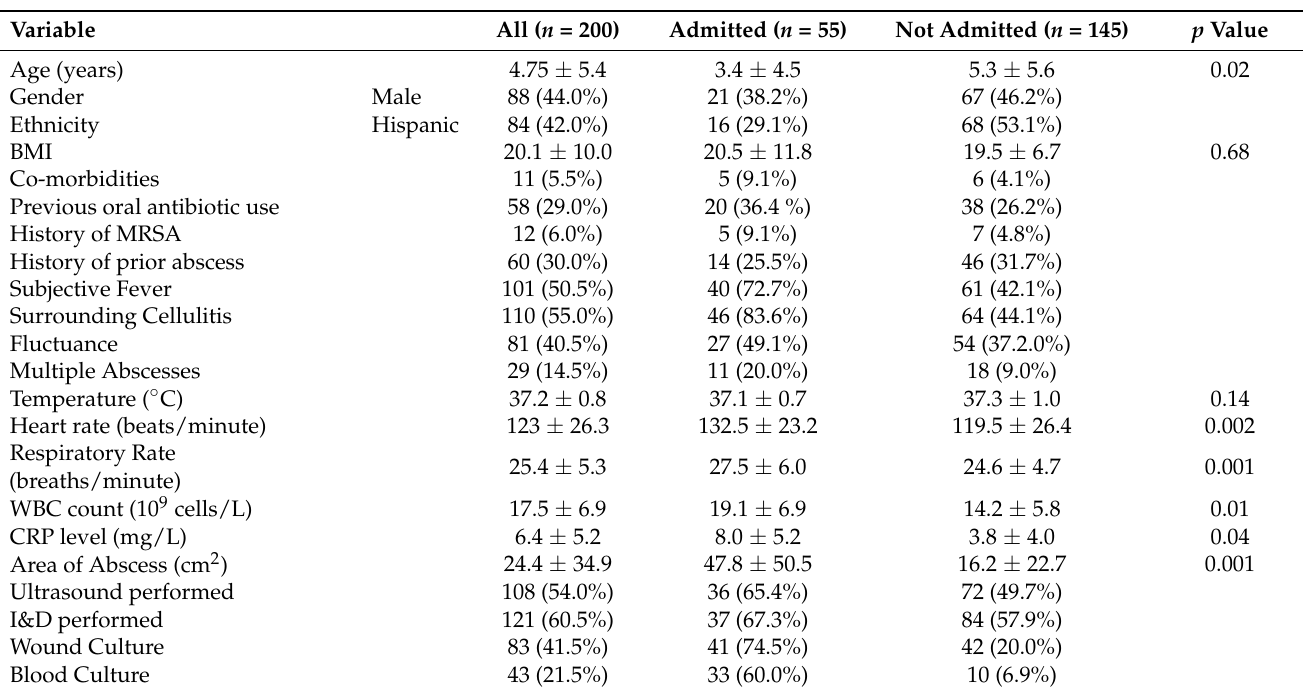
Table 3. Factors for hospital admissions.